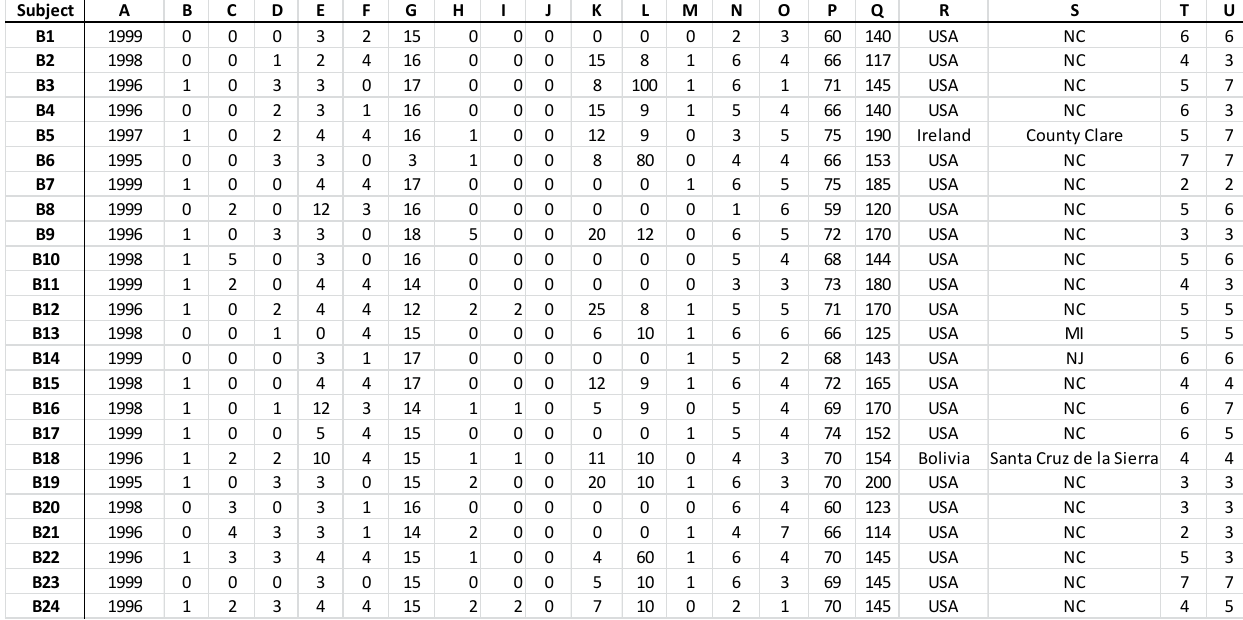
Figure A14. Individual Demographic Data—Session B.